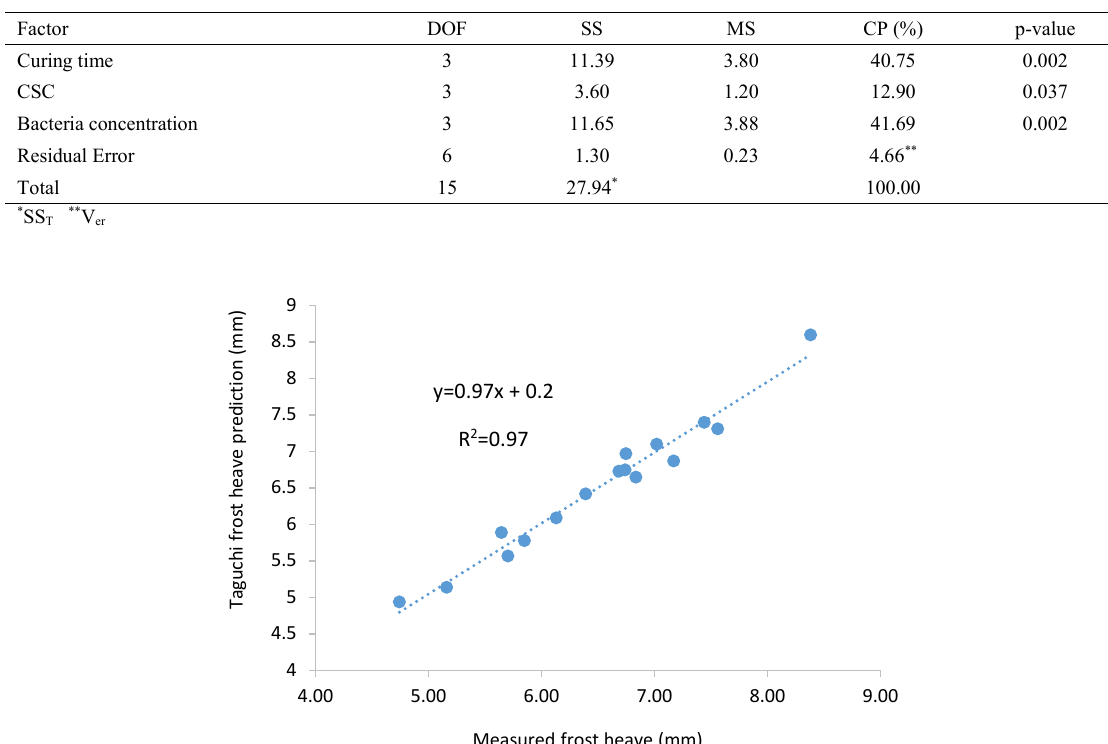
Table 6: ANOVA results